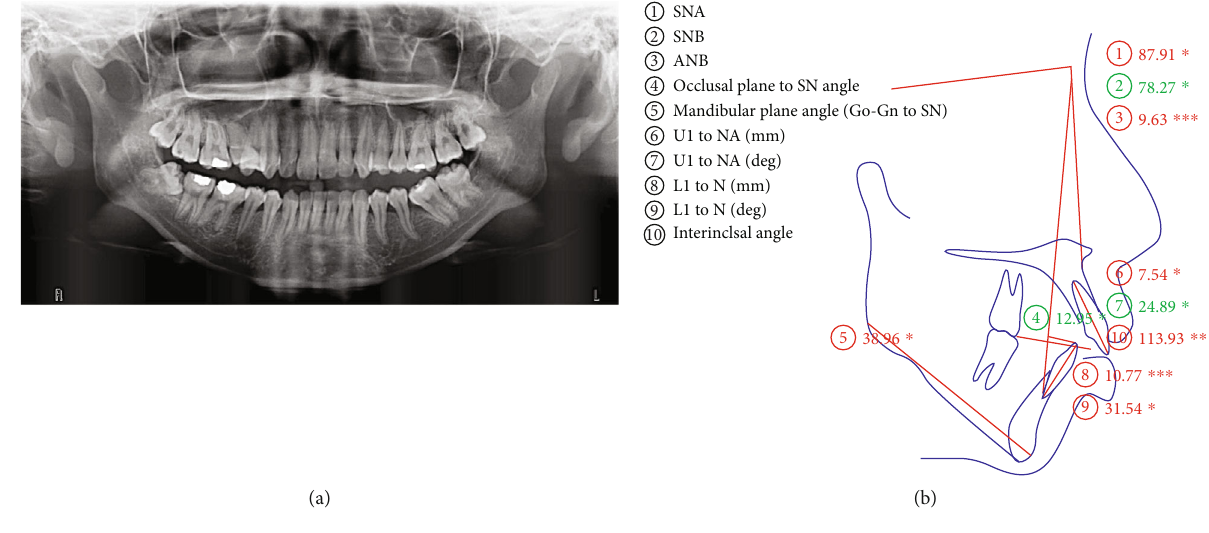
Figure 2: (a) Pretreatment OPG and (b) lateral cephalogram tracing with values. Table 1: Archwires used in di ff erent stages with time intervals.